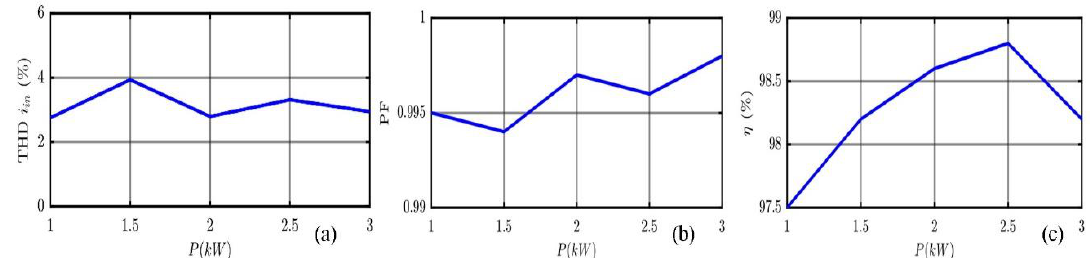
Figure 13. The graphic behaviors of the current THD ( a ), the power factor, ( b ) and the converter efficiency, and ( c ) of the interleaved three cells PFC front-end converter in the range of 1–3 kW.